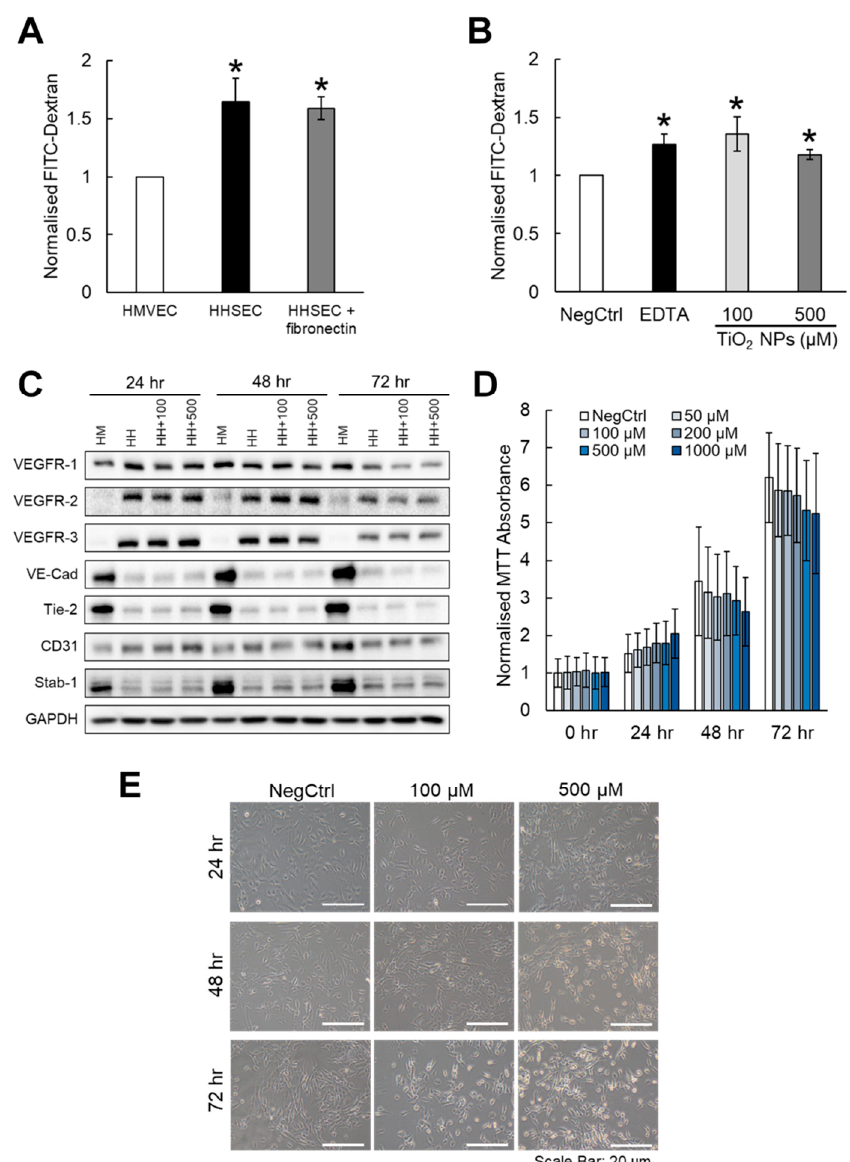
Figure 2. TiO 2 NPs induced endothelial leakiness in human hepatic sinusoidal endothelial cells (HHSECs) without compromising endothelial biomarkers. ( A ) Transwell permeability assay revealed higher fluorescein isothiocyanate (FITC)-dextran leakiness exhibited by HHSECs compared to human microvascular endothelial cells (HMVECs). Fibronectin coating did not significantly reduce the leakiness of HHSECs. ( B ) TiO 2 NPs significantly increased the leakiness in HHSECs at two different concentrations of 100 µ M and 500 µ M, compared to the untreated control (NegCtrl). EDTA was used as a positive control. ( C ) Western blot analyses showed that the exposure of HHSECs to TiO 2 NPs did not result in observable changes to endothelial biomarkers up to 72 h. Glyceraldehyde 3-phosphate dehydrogenase (GAPDH) was used as a loading control. ( D ) HHSECs treated with various concentrations of TiO 2 NPs up to 72 h did not exhibit significant difference in cell viability compared to the non-treated control (NegCtrl) at the same time point. ( E ) Treatment of TiO 2 NPs resulted in observable morphological changes to the cells leading to cellular detachment, particularly after exposure to a higher concentration (500 µ M) at the 72-h timepoint. Scale bar = 20 µ m. Data represent mean ± SE ( n = 3), Student’s t -test, * p < 0.05.